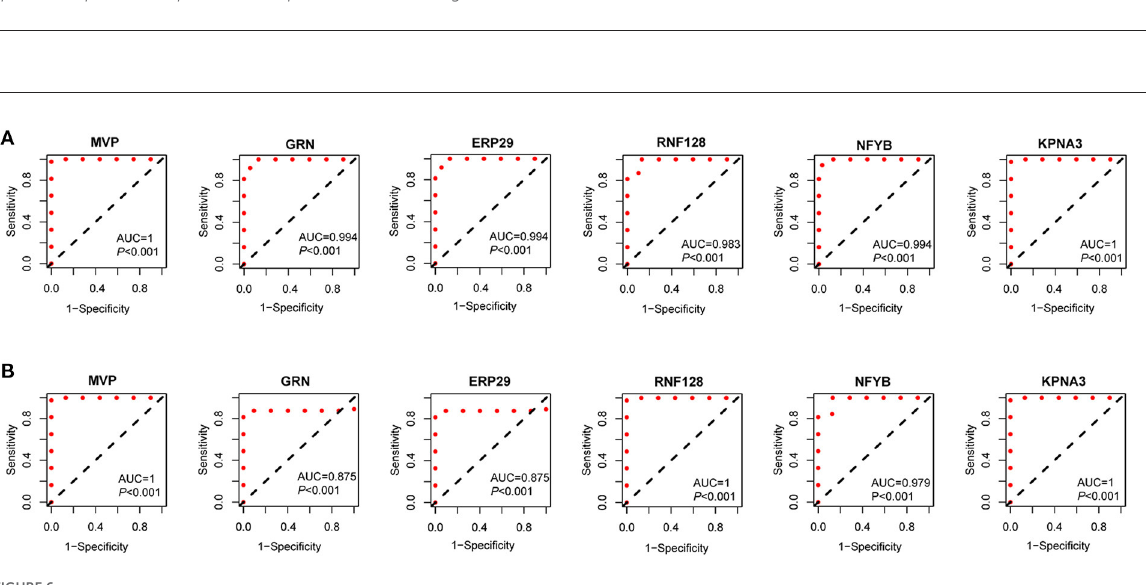
FIGURE5 Expression validation of seven genes. (A) Expression of MVP , GRN , ERP29 , RNF128 , NFYB , KPNA3 and PRKN in dysferlinopathy ( n = 10) compared with controls ( n = 18) in the GSE3307 dataset. (B) Expression of MVP , GRN , ERP29 , RNF128 , NFYB , KPNA3 and PRKN in dysferlinopathy ( n = 8) compared with controls ( n = 6) in the GSE109178 dataset. PRKN was the only gene with an expression level not statistically significant in the GSE109178 dataset. (C) Expression of MVP , GRN , ERP29 , RNF128 , NFYB , KPNA3 and PRKN in four dysferlinopathy patients compared to four controls by qRT-PCR. A Student’s non-parametric t -test with a P -value of 0.05 was taken to compare the two groups. * p < 0.05; ** p < 0.01; *** p < 0.001; **** p < 0.0001; ns, non significance.